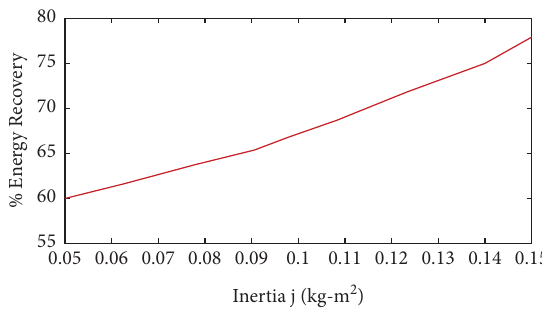
Figure 18: Plot of % energy recovery vs. inertia j (kg m 2 ).